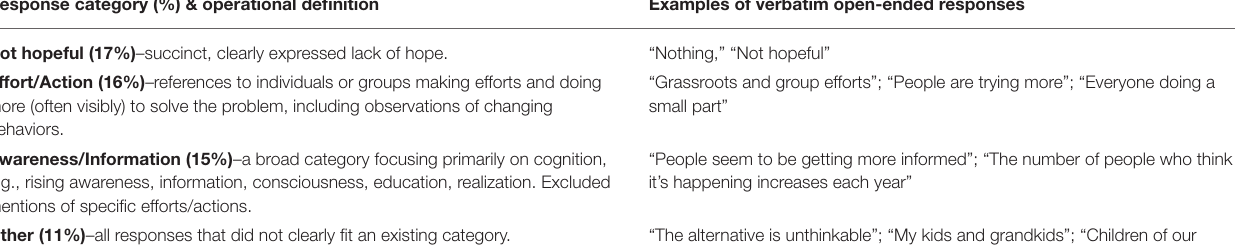
TABLE 2 | Open-ended responses about what is making Americans hopeful about climate change. Response category (%) & operational definition Examples of verbatim open-ended